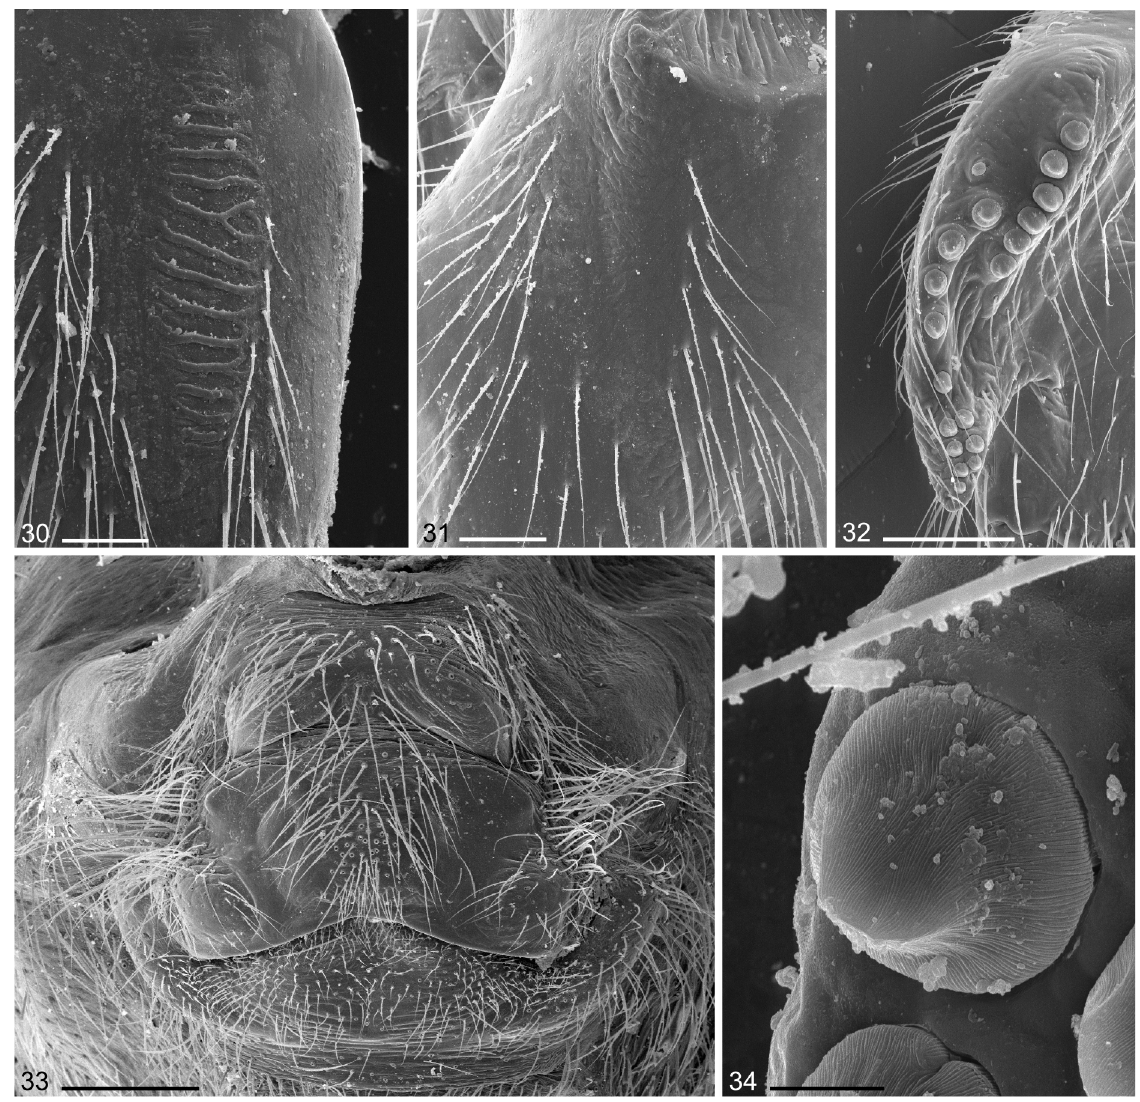
Figs 30–34. Artema atlanta Walckenaer, 1837, ZFMK Ar 15217 (♀) and ZFMK Gui 82 (♂). 30 . Female stridulatory ridges. 31 . Absence of male stridulatory ridges. 32 . Male chelicerae with frontal row of modified (cone-shaped) hairs. 33 . Epigynal plate. 34 . Modified (cone-shaped) hair on chelicerae process. Scale lines: 30–31 = 0.1 mm; 32 = 0.2 mm; 33 = 0.6 mm; 34 =